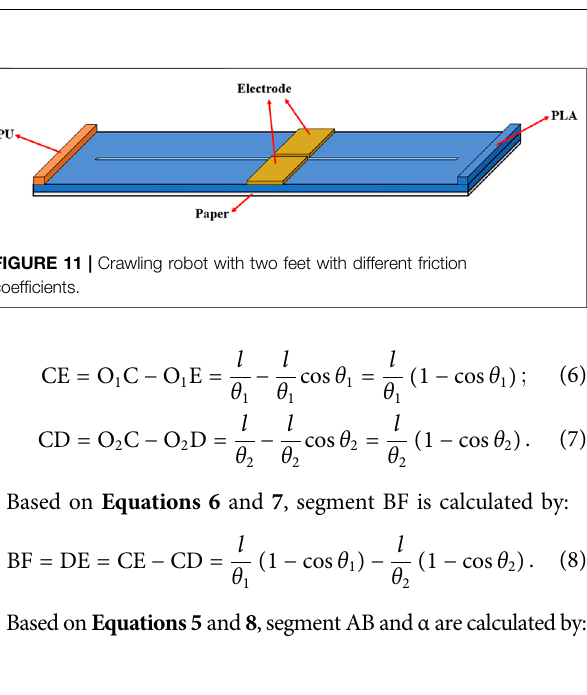
FIGURE 10 | Two reversible bilayer structures actuated (A) simultaneously (B) with a wave-like strategy.